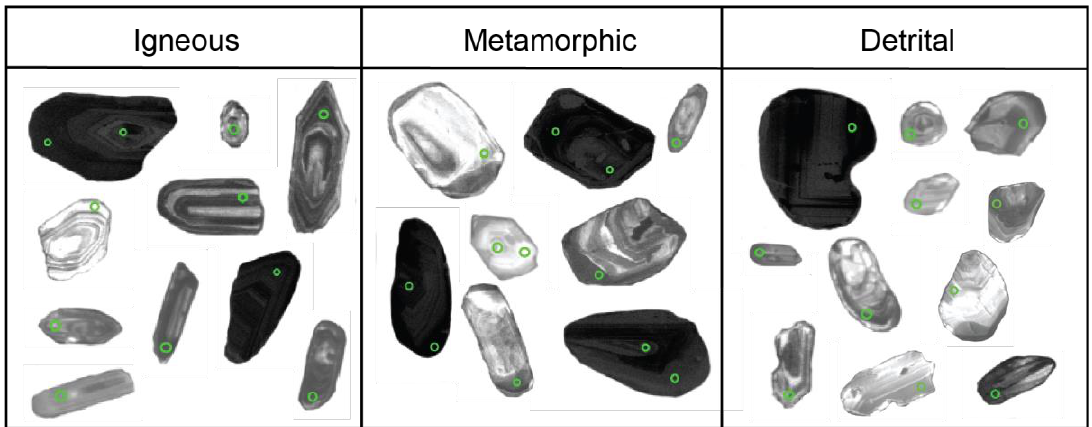
Figure 3. A range of detrital zircon morphologies and the zonation CL images grains from all 11 samples. The ~20 μm laser ablation spots are indicated by circles on the individual grains.